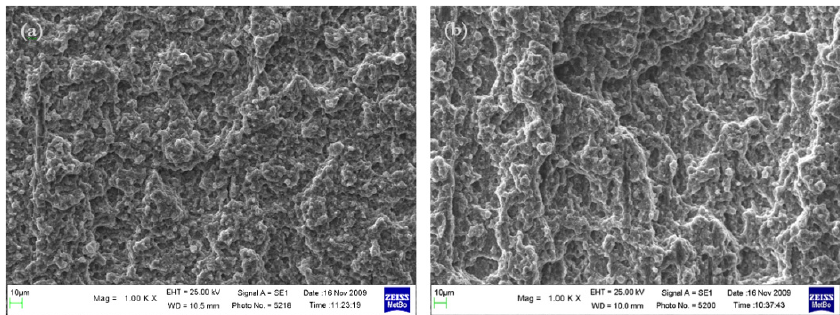
Figura 16: Micrografie SEM delle superfici di frattura dei provini di